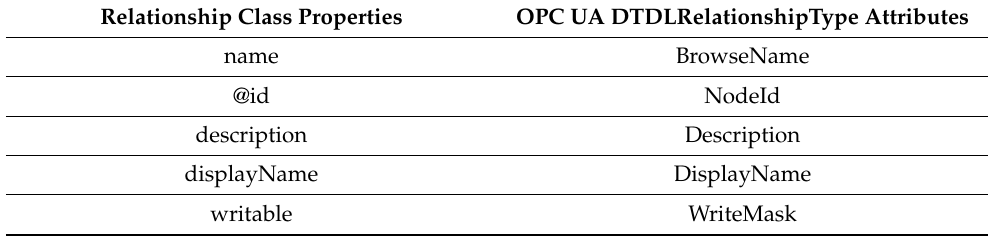
Table 12. Mapping of properties of the Relationship class into the OPC UA DTDLRelationshipType attributes.